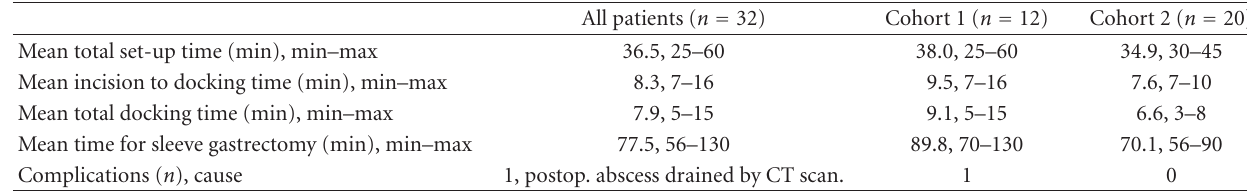
Table 2: Operating times and postoperative